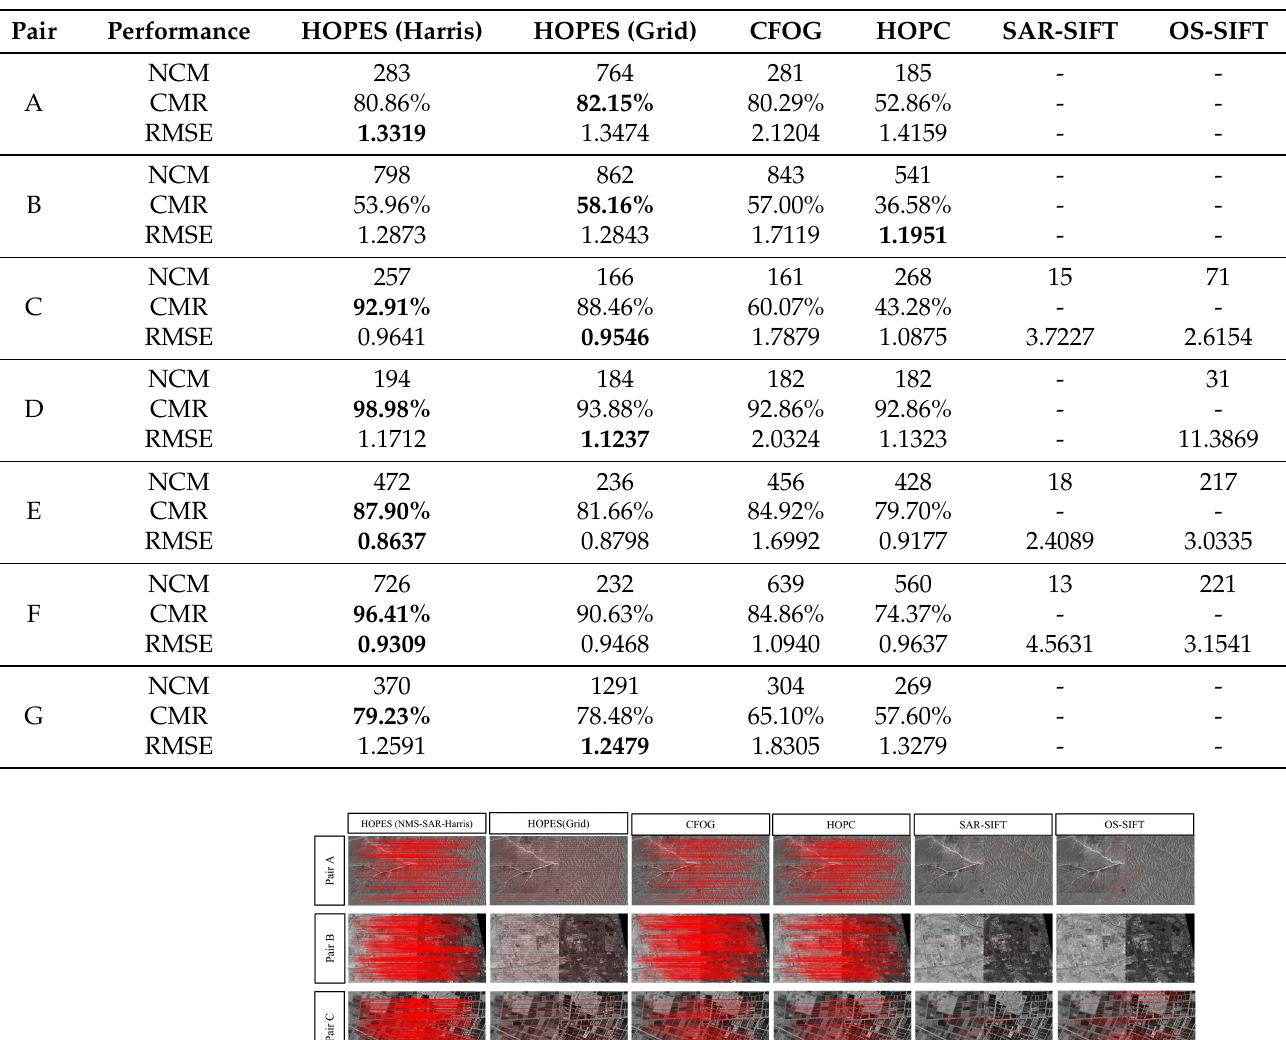
Table 4. NCM, MCR and RMSE values of different matching strategies.